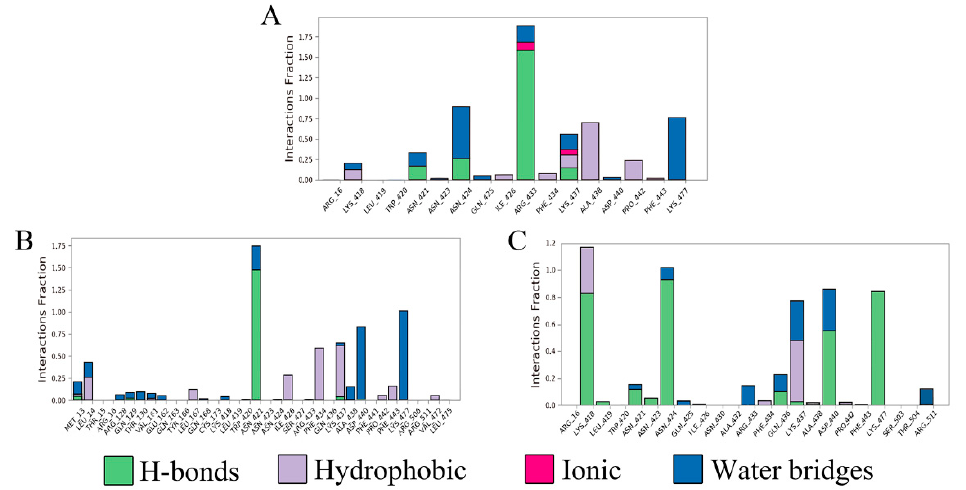
Figure 6. Protein–ligand contact interaction over trajectory with respect to BIBR1532 ( A ), compound 5c ( B ) and compound 6c ( C ).